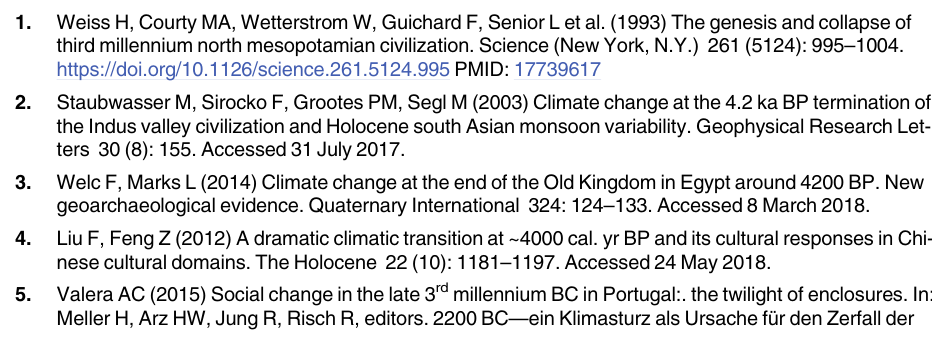
S1 Fig. Cross-plots and correlations of environmental and paleoclimatological parameters of sediment core ODP-161-976A. S2 Fig. Concentration of individual n -alkane homologues from sediment core ODP-161-